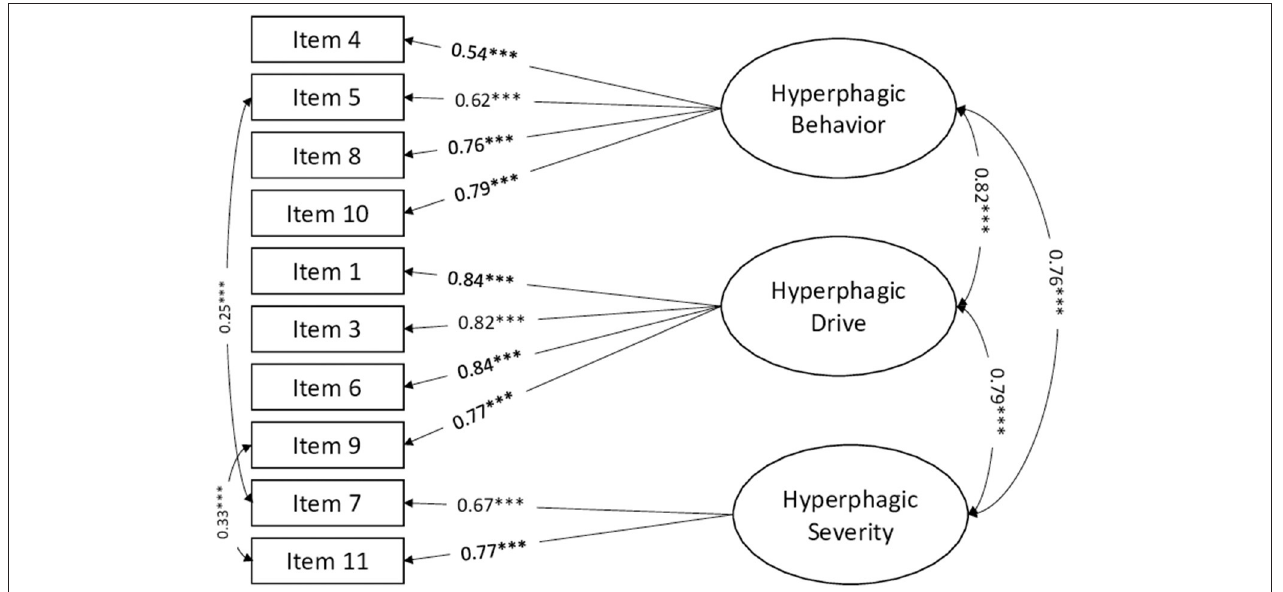
FIGURE 1 | Standardized factor loadings and latent correlations among the three factors of the HQ. *** p < 0.001.